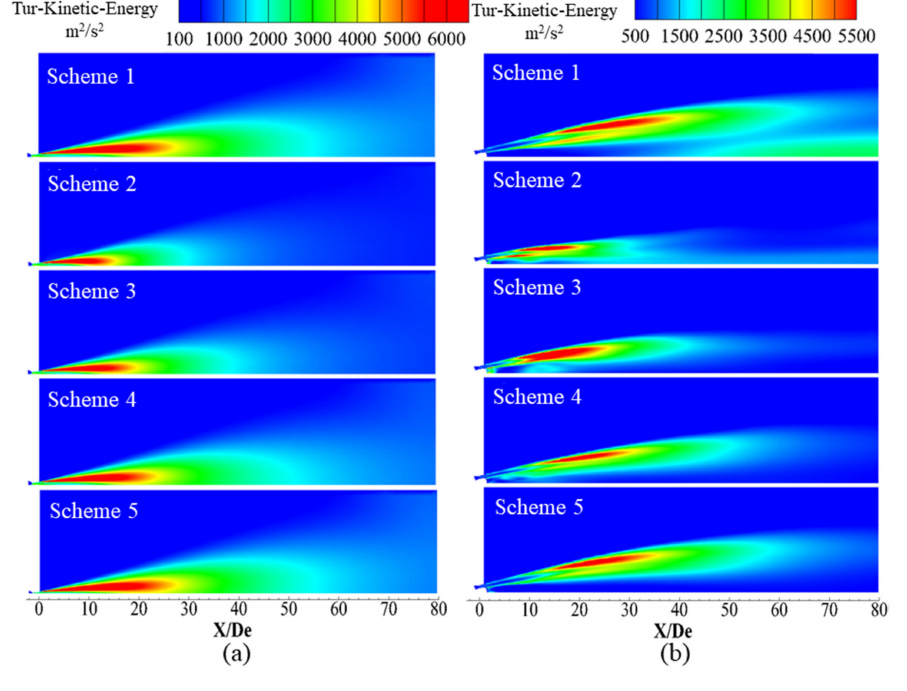
Figure 13. Turbulent kinetic energy distribution of the supersonic jet along the longitudinal section. ( a ) Laval nozzle and ( b ) lance